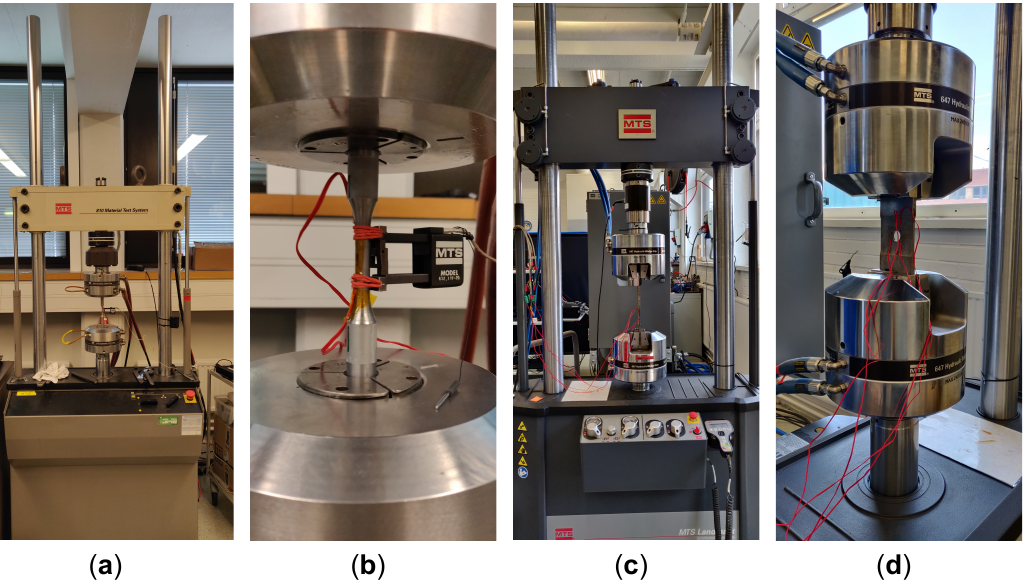
Figure 4. Experimental test setup used in the material model parameter estimation experiments and the validation experiments: ( a ) MTS-810 test system with a dog-bone specimen specimen, ( b ) instrumented dog-bone specimen with extensometer, ( c ) MTS-370.50 test system with a flat specimen, ( d ) instrumented flat